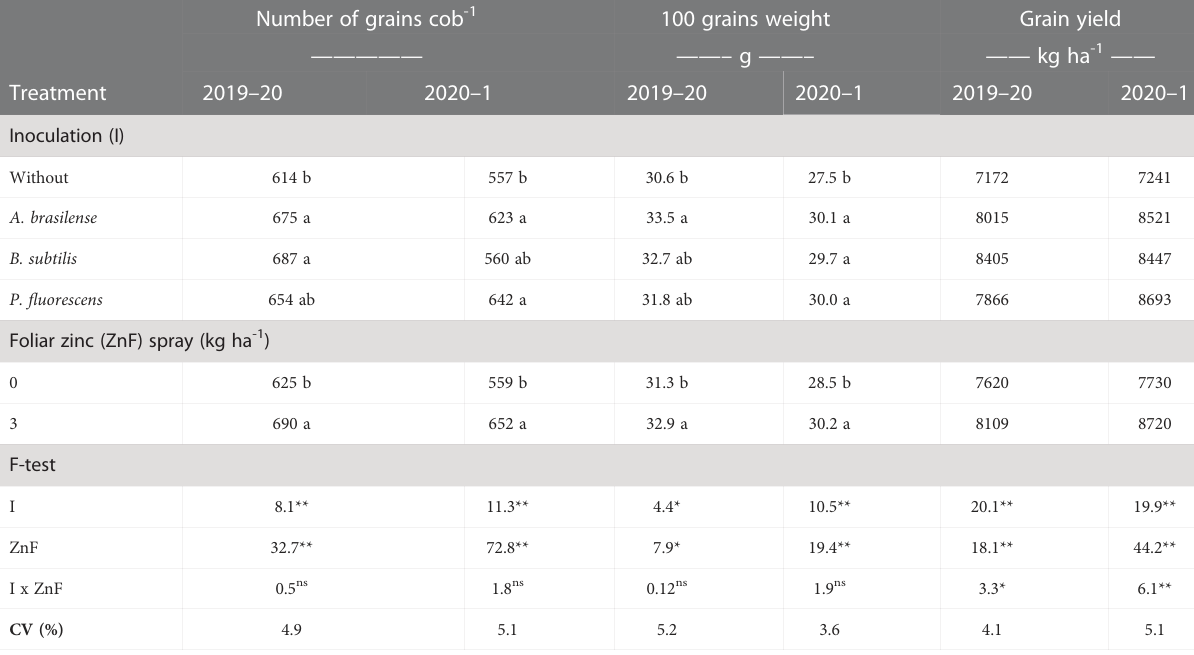
TABLE 3 Number of grains cob -1 , 100-grains weight, and grain yield as a function of plant growth-promoting bacteria inoculation, together with or without nano-zinc oxide spray in the 2019 – 20 and 2020 – 1 cropping seasons. Number of grains cob